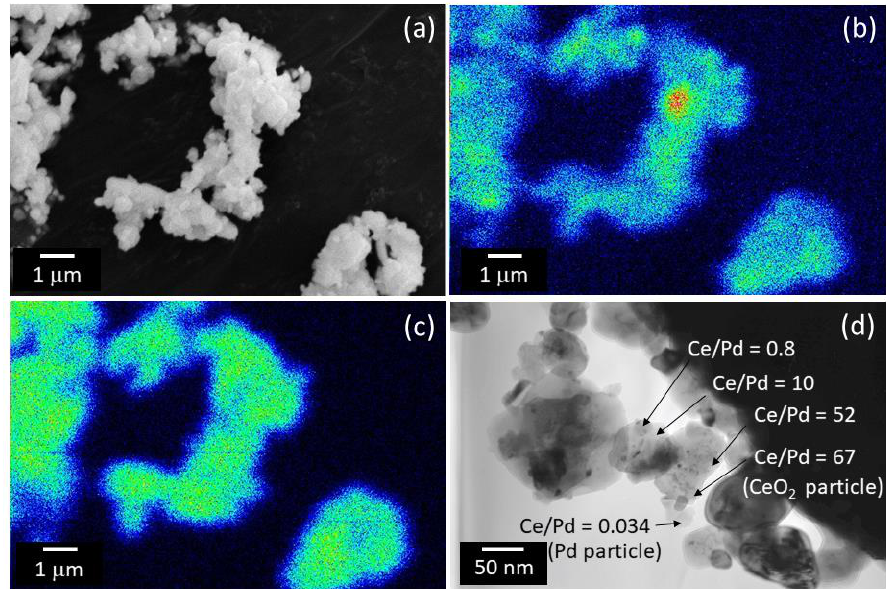
Figure 7. Microscopic observation of PdCe4 after heating at 900 °C for 2 h. ( a ) Secondary electron image and elemental mapping of ( b ) Pd and ( c ) Ce obtained by SEM − EDS. ( d ) TEM image with atomic ratios obtained by EDS.